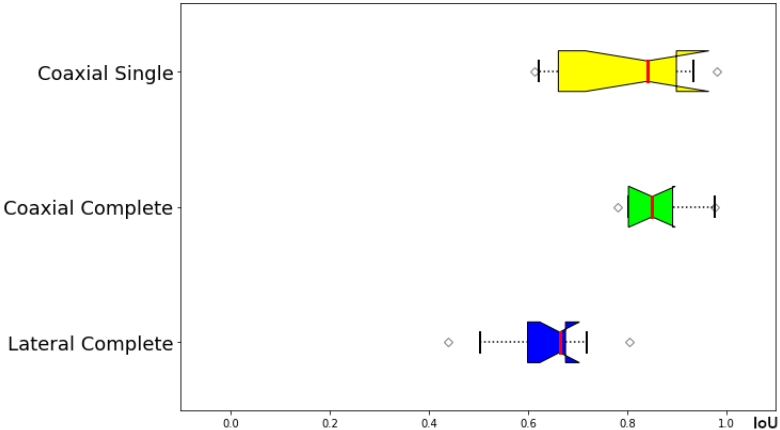
Figure 5. Comparison of the IoU of the different input data sets. All three models are trained with the weighted dice coefficient